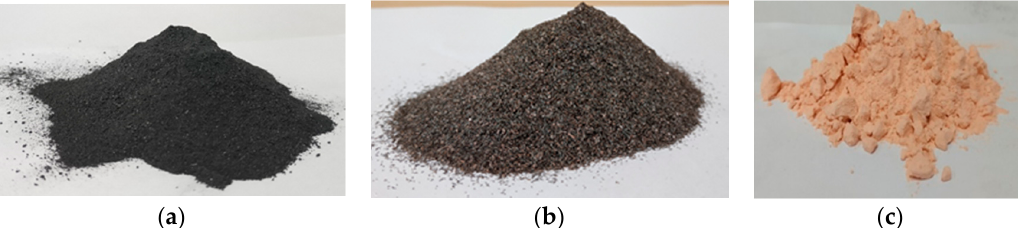
Figure 2. Components for making up trolleybus brushes from recycled materials, ( a ) carbon powder made from used electrodes, ( b ) shredded copper braid, ( c ) phenolic-acrylic resin.